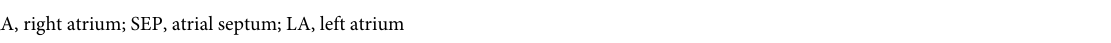
tivity and specificity of RA-CSp were 0.88 and 0.96, and those of RA-CSd were 0.91 and 0.65, respectively. An algorithm to differentiate the area of non-PV trigger was developed by incorporat- ing the two cut-off values of intra-atrial interval; RA-CSp of 50 ms and RA-CSd of 0 ms (Fig 4). Diagnostic accuracy of this algorithm in the present 37 non-PV triggers was vali- dated. Sensitivity and specificity for RA non-PV trigger were 88% and 97%, respectively; for SEP non-PV, 81% and 73%, respectively; for LA non-PV, 65% and 95%, respectively (Table 3). Table 2. Incidences of non-PV trigger firing and the number of cardioversion for AF.